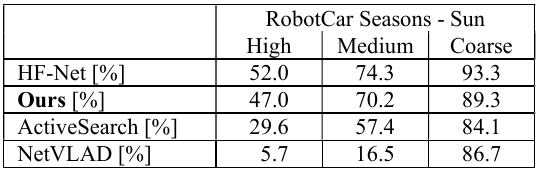
Table 2. Results for the RobotCar Seasons Benchmark (‘Sun’